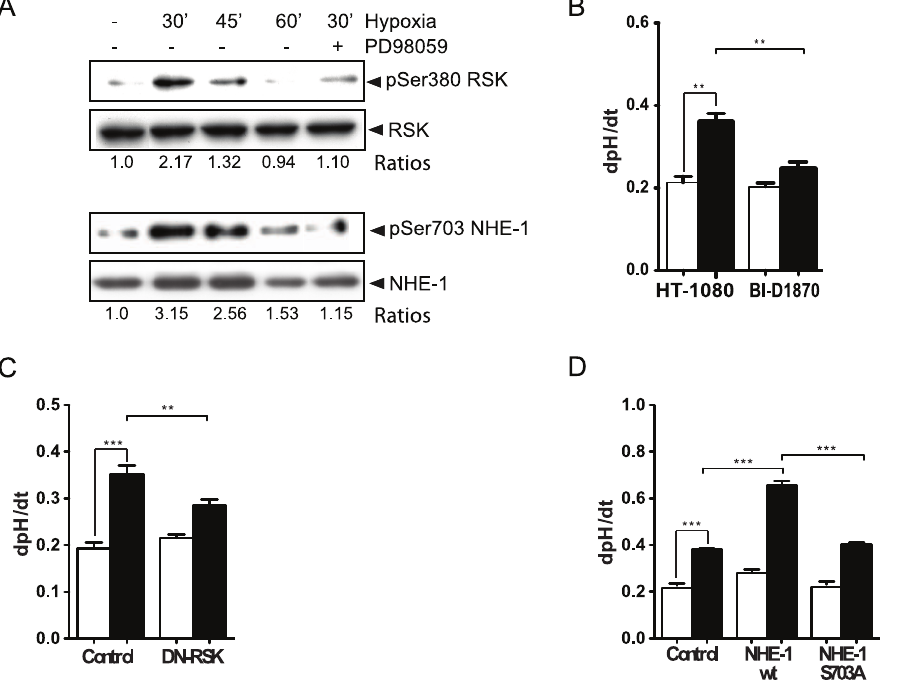
Figure 5. RSK-induced NHE-1 phosphorylation increases its activity in hypoxia. (A) HT-1080 cells were cultured for the indicated periods of time under normoxic or hypoxic conditions or for 30 min under hypoxia with the addition of the MEK1/2 inhibitor PD98059 (50 m M). Representative immunoblots showing p90RSK Ser 380 phosphorylation and NHE-1 Ser 703 phosphorylation. NHE-1 phosphorylation was revealed using antibodies directed against the 14-3-3 binding motif, following NHE-1 immunoprecipitation. Ratios of pRSK to total RSK and pNHE-1 to total NHE-1 are shown (n=3). (B-D) Na + /H + exchange rates were measured in cells exposed to normoxia (empty bars) or hypoxia (filled bars) in (B) the presence or absence of the p90RSK inhibitor BI-D1870 (10 m M) (n=3), or (C) cells transfected with a dominant negative p90RSK (n=3), or (D) cells transfected with WT NHE-1 or a S703A substitution NHE-1 mutant (n=3). Columns represent the mean 6 SEM indicated by the horizontal bars. The asterisks correspond to, ** p , 0.001; *** p ,